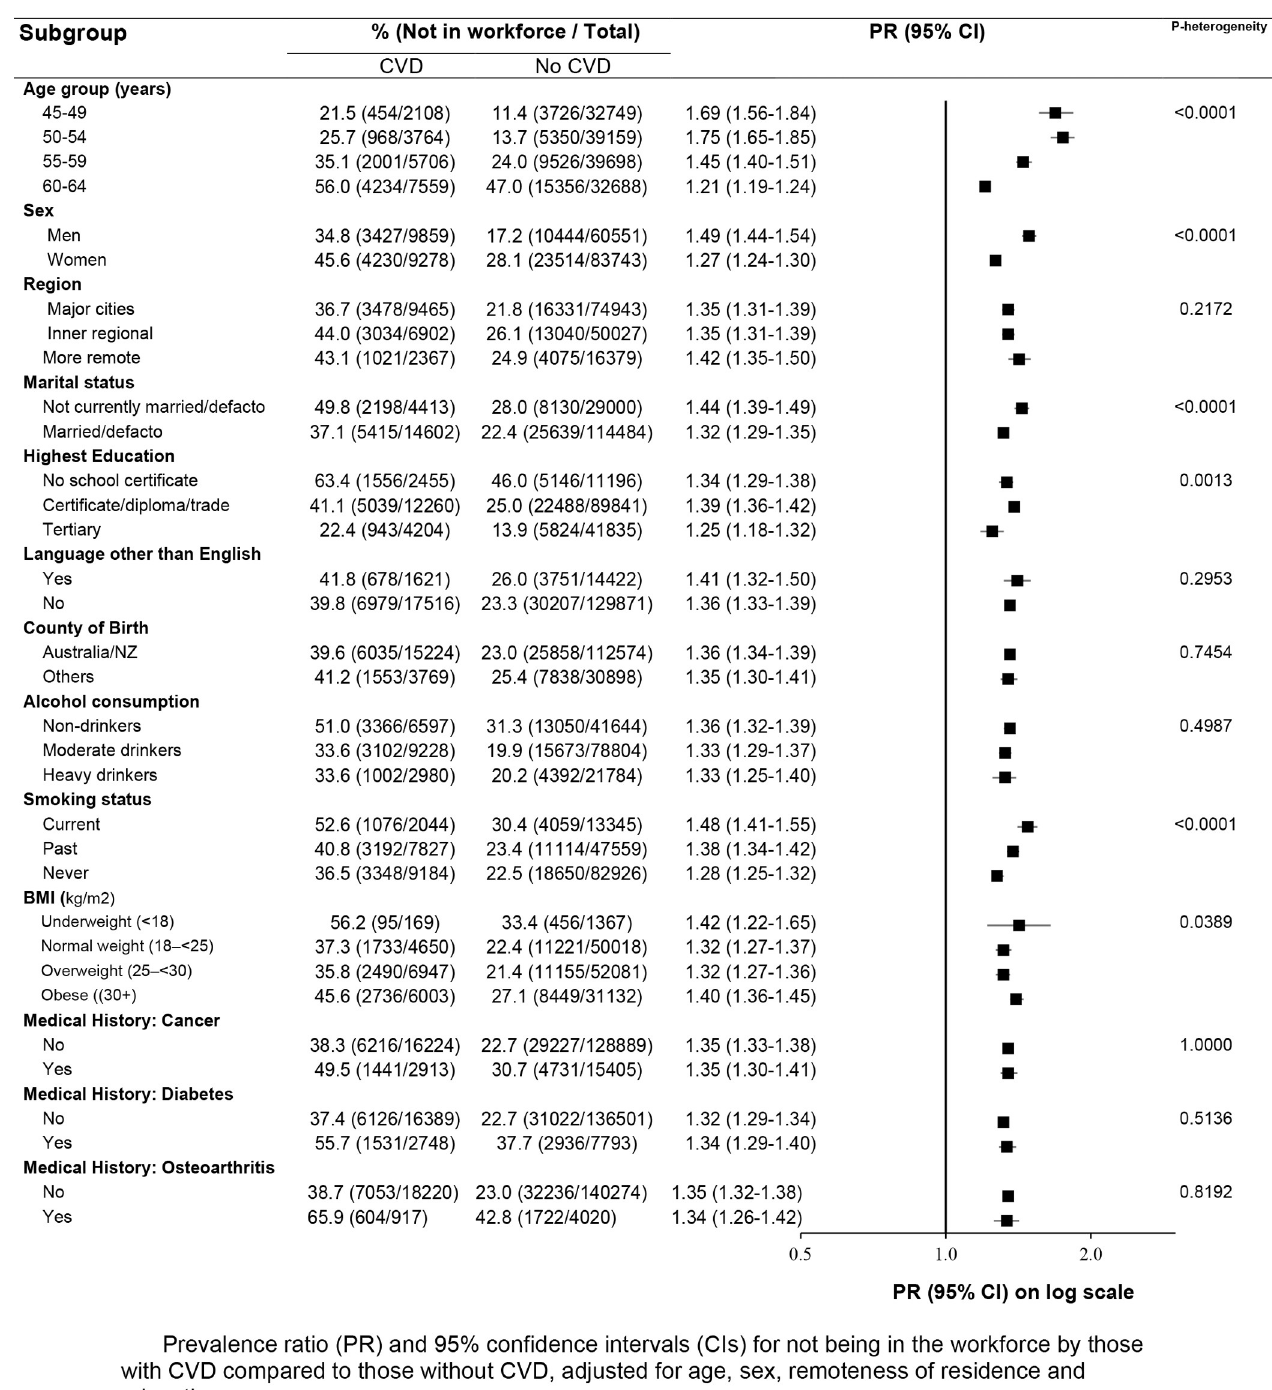
Fig 3. Prevalence ratio of not in workforce in population subgroups based on socio-demographic and health related factors. https://doi.org/10.1371/journal.pone.0249738.g003 16% of those without CVD; among participants with severe functioning limitations, 73% of those with CVD, and 60% of those without CVD, were not working. After adjustment for